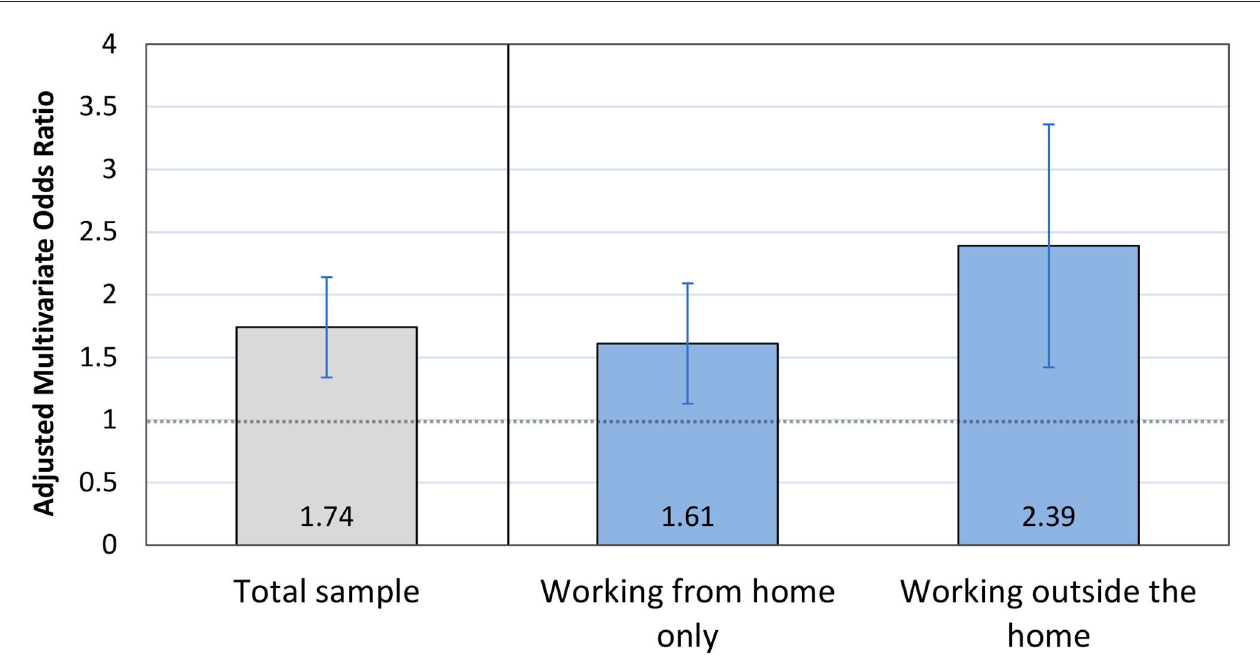
FIGURE 1 | Prenatal depression and COVID-19-related work-plan changes. Odds ratio and 95% confidence interval from multivariate regression model predicting clinically significant depression symptoms in response to experiencing a work-plan change. Results are shown within the total sample (in gray); and then stratified according to whether individuals worked entirely from home or outside of the home during the pandemic (in blue).